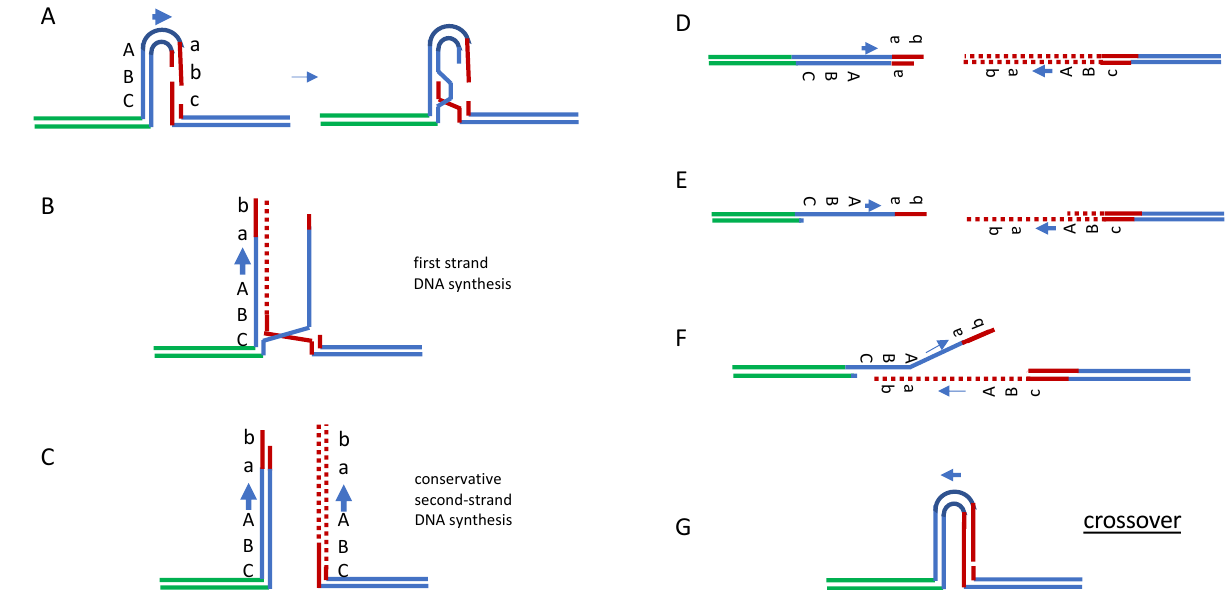
Figure 3. Rad51-independent repair by break-induced replication and single-strand annealing. Extended SDSA can be modeled in yeast by recombination between inverted repeated sequences in which one repeat suffers a DSB. Break-indued replication ( A – C ), followed by resection of the ends ( D , E ) and SSA ( F ), will complete repair that can result either in a crossover (shown, ( G )) or noncrossover with equal